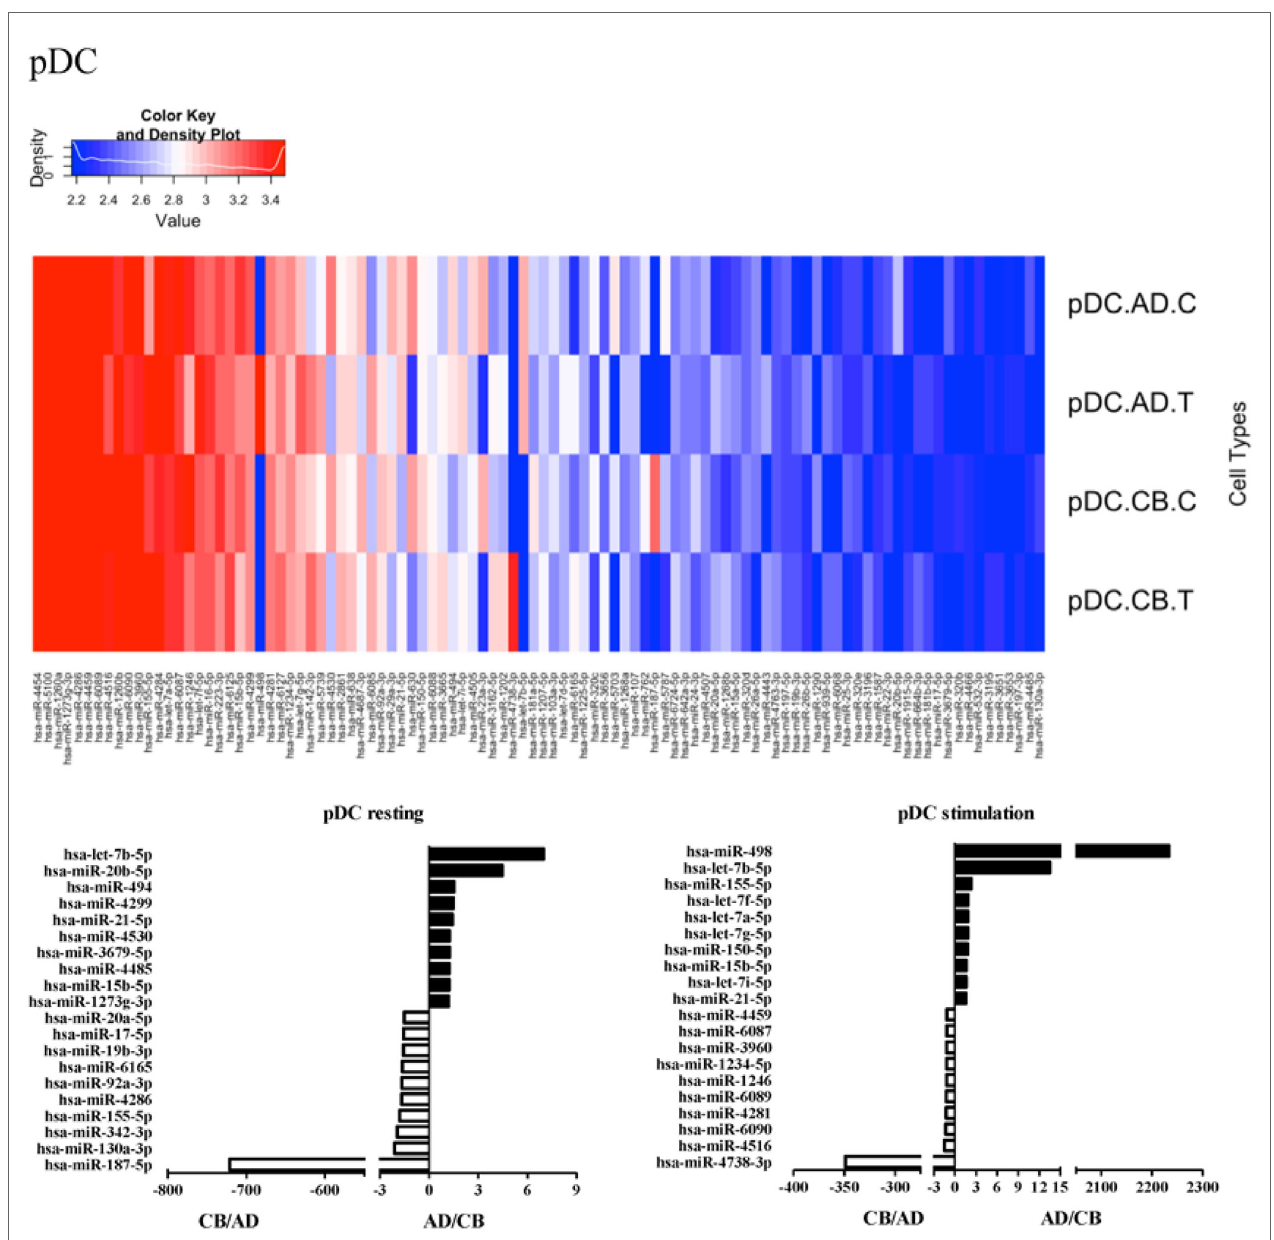
FigUre 10 | Differential microrna profiles between adult and neonatal plasmacytoid dendritic cells